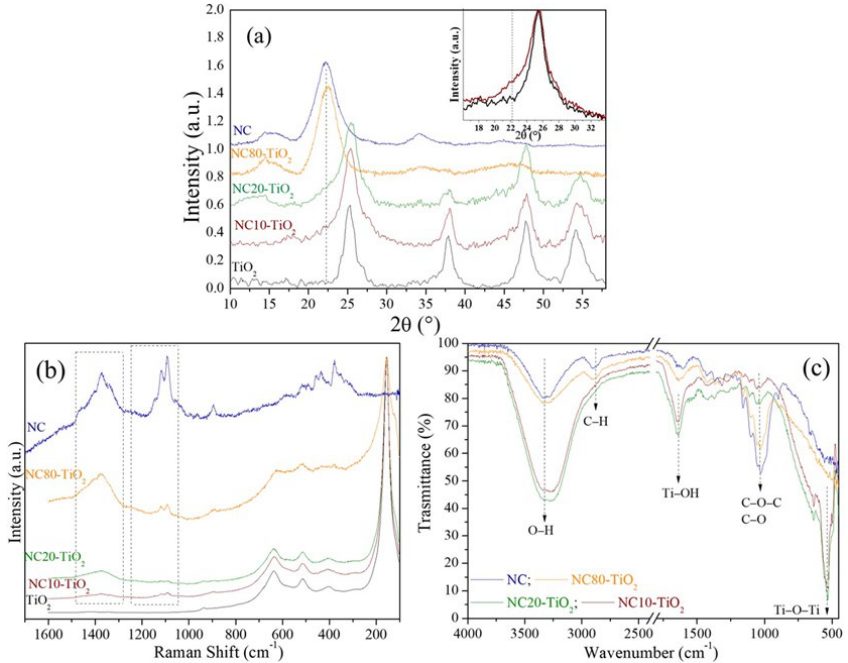
Figure 1. ( a ) XRD patterns of ( – ) NC, ( – ) TiO 2 , ( – ) NC80-TiO 2, ( – ) NC20-TiO 2 , and ( – ) NC10–TiO 2 nanocomposites. The inset shows a comparison between the (101) peak of TiO 2 and NC20–TiO 2 ; ( b ) μ- Raman spectra and ( c ) FTIR spectra for nanocellulose (NC) and NC–TiO 2 nanocomposites.